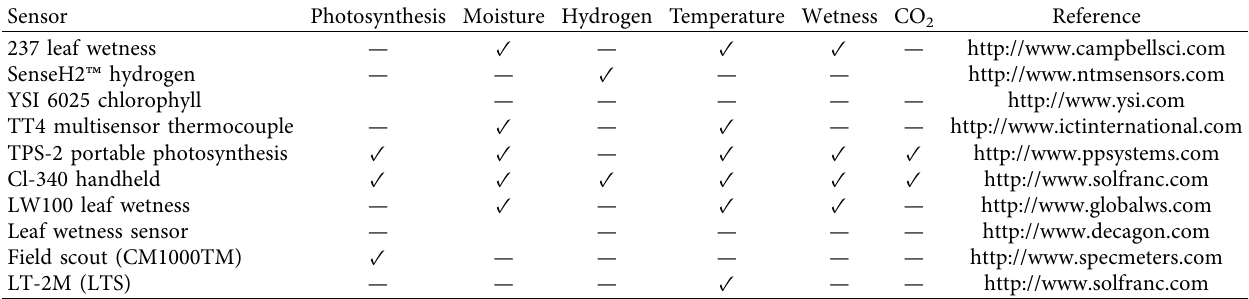
Table 3: Sensors used for irrigation control systems in farming domains (leaf/plant). Sensor